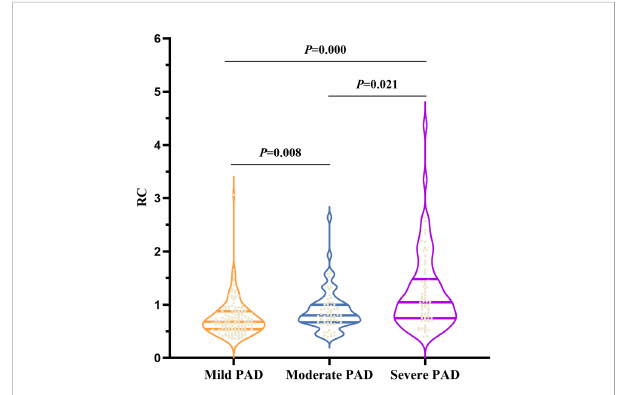
FIGURE 1 The RC levels according to PAD severity based on ultrasound results. RC, remnant cholesterol. In the violin plot, the three horizontal lines from top to bottom represent the upper quartile, the median, and the lower quartile in order. P < 0.05 (two-sided) was de fi ned as statistically signi fi cant. Bold values indicate statistically signi fi